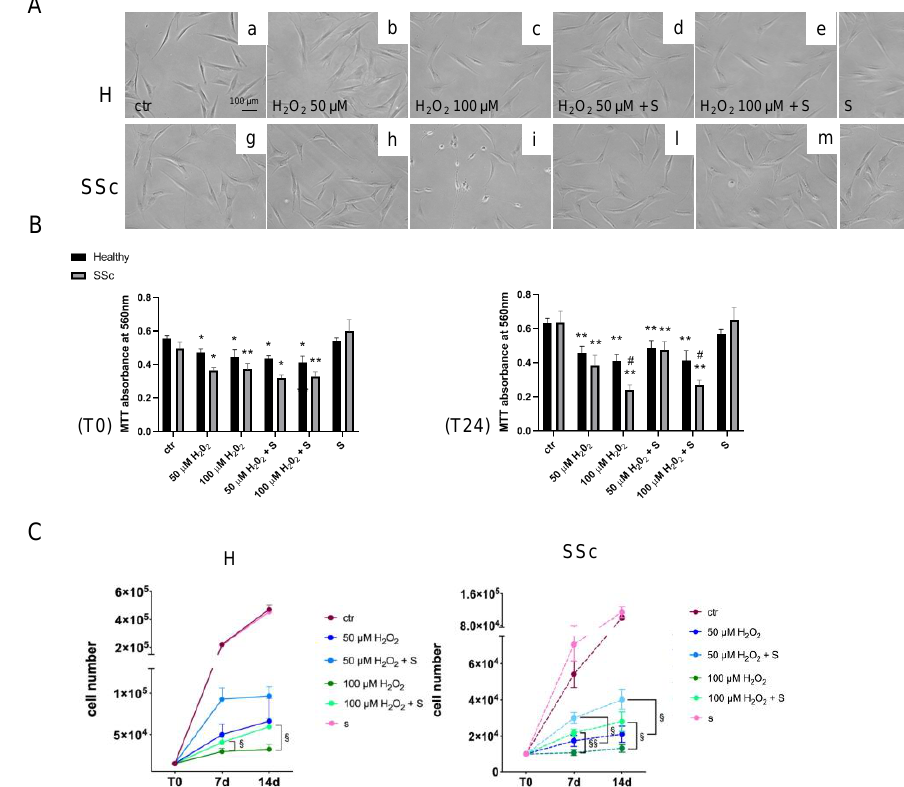
Figure 4. Analysis of the cell proliferation in healthy control (H) and SSc fibroblasts exposed to a pro-oxidant environment. ( A ) Morphological changes in H and SSc fibroblasts at the basal level (panels a,g) treated with 50 (panels b,h) and 100 µM H 2 O 2 (panels c,i) for 24 h in the presence or in absence of sildenafil 1 µM (panels d-f,l-n). Scale Bar = 100 µm. ( B ) Cell viability was measured in healthy (black columns) and SSc fibroblasts (grey columns) stimulated with 50 and 100 µM H 2 O 2 for 1 h (T0, left panel) and 24 h (T24, right panel) in the presence or in absence of sildenafil 1 µM. ( C ) Cell proliferation analysis in H (left panel) and SSc fibroblasts (right panel) treated with 50 and 100 µM H 2 O 2 for 1 h in the presence or in absence of sildenafil 1 µM at the basal level (T0) after 7 days (7 d) and 14 days (14 d) of washing from the treatment. * p < 0.05, ** p < 0.01 vs. ctr, # p < 0.05 healthy vs. SSc, § p < 0.05, and §§ p < 0.01 H 2 O 2 vs. H 2 O 2 + S. Data are expressed as mean ± SE. S, sildenafil.